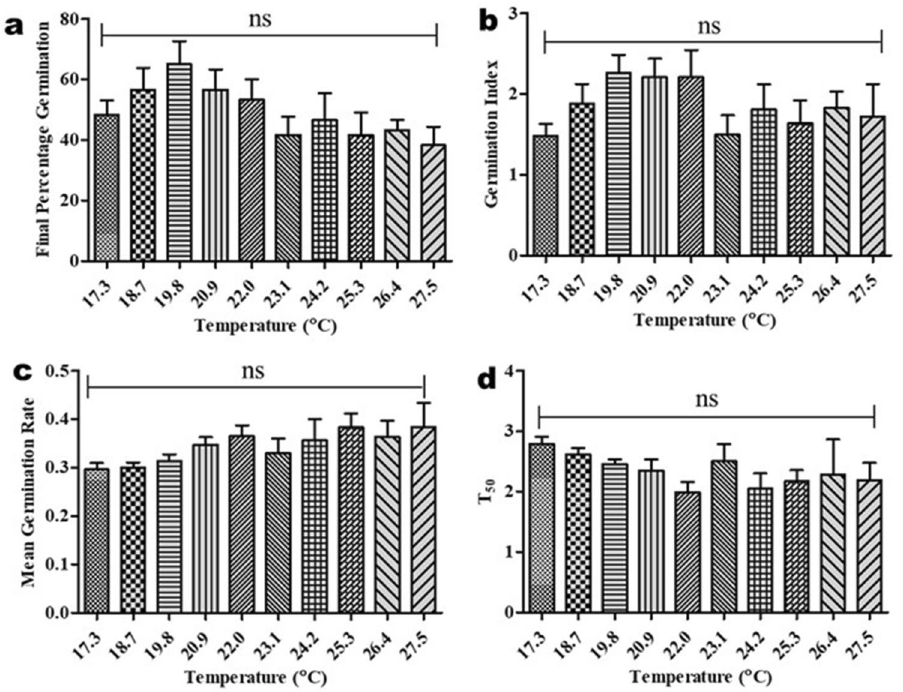
Figure 2. Effect of temperature on in vitro seed germination parameters of A. africana. ( a ) Final Percentage Germination ( b ) Germination Index ( c ) Mean Germination Rate ( d ) time required for 50% germination (T 50 ). Values are presented as means ± standard error. ns-not statistically significant by Tukey’s multiple comparison test and p =